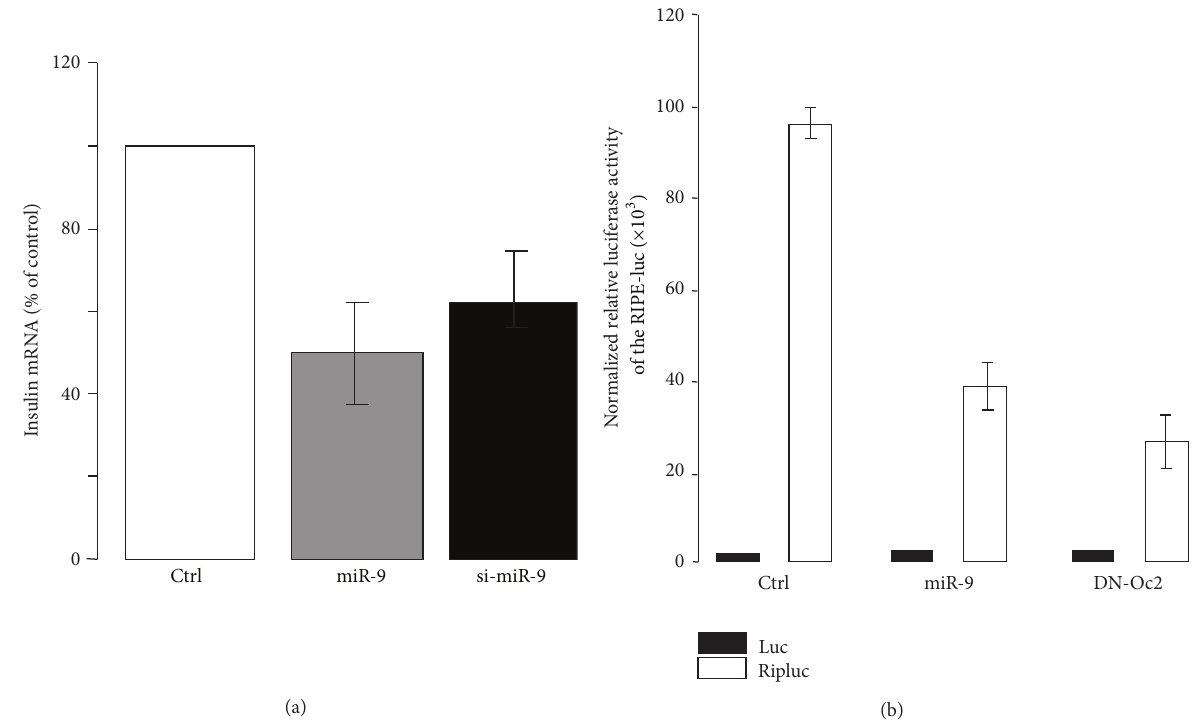
Figure 1: Role of miR-9 in insulin mRNA and promoter activity. (a) Effect of miR-9 on insulin mRNA. The RNA duplex containing the mature form of miR-9 [26] and a siRNA directed against miR-9 (si-miR-9) or a control oligonucleotide was transfected in MIN6 cells for 48 hrs. The expression of the preproinsulin mRNA was measured by quantitative PCR. The mRNA level was normalized against the housekeeping acidic ribosomal phosphoprotein P0 gene ( Rplp0 ) and the expression level in cells transfected with the control siRNA was set to 100%. Data are the mean of ± SEM of 3 independent experiments. (b) Effects of miR-9 and dominant negative Oc2 mutant on the activity of an insulin reporter construct in MIN6 cells. MIN6 cells were transiently transfected with miR-9 RNA duplexes containing the mature form of miR-9 [26] or the dominant negative Oc2 mutant [26]. The cells were cotransfected with a luciferase reporter construct driven by a 600 bp fragment of the rat insulin promoter (Ripluc) and with pRLSV40, a construct producing a renilla luciferase activity under the control of the constitutive SV40 promoter. The firefly luciferase activity produced by Ripluc was normalized to the renilla luciferase activity to rule out differences in the transfection efficiency. The empty pGL3 basic (luc) was used as control. Each experiment was performed at least three times in